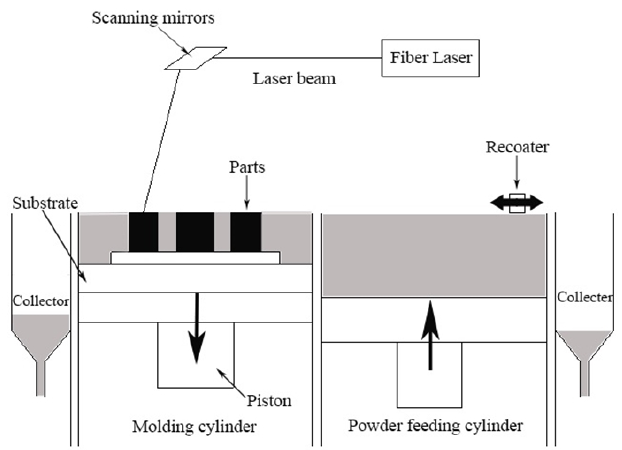
Figure 2. The schematic illustration of the XJRP SLM molding machine.